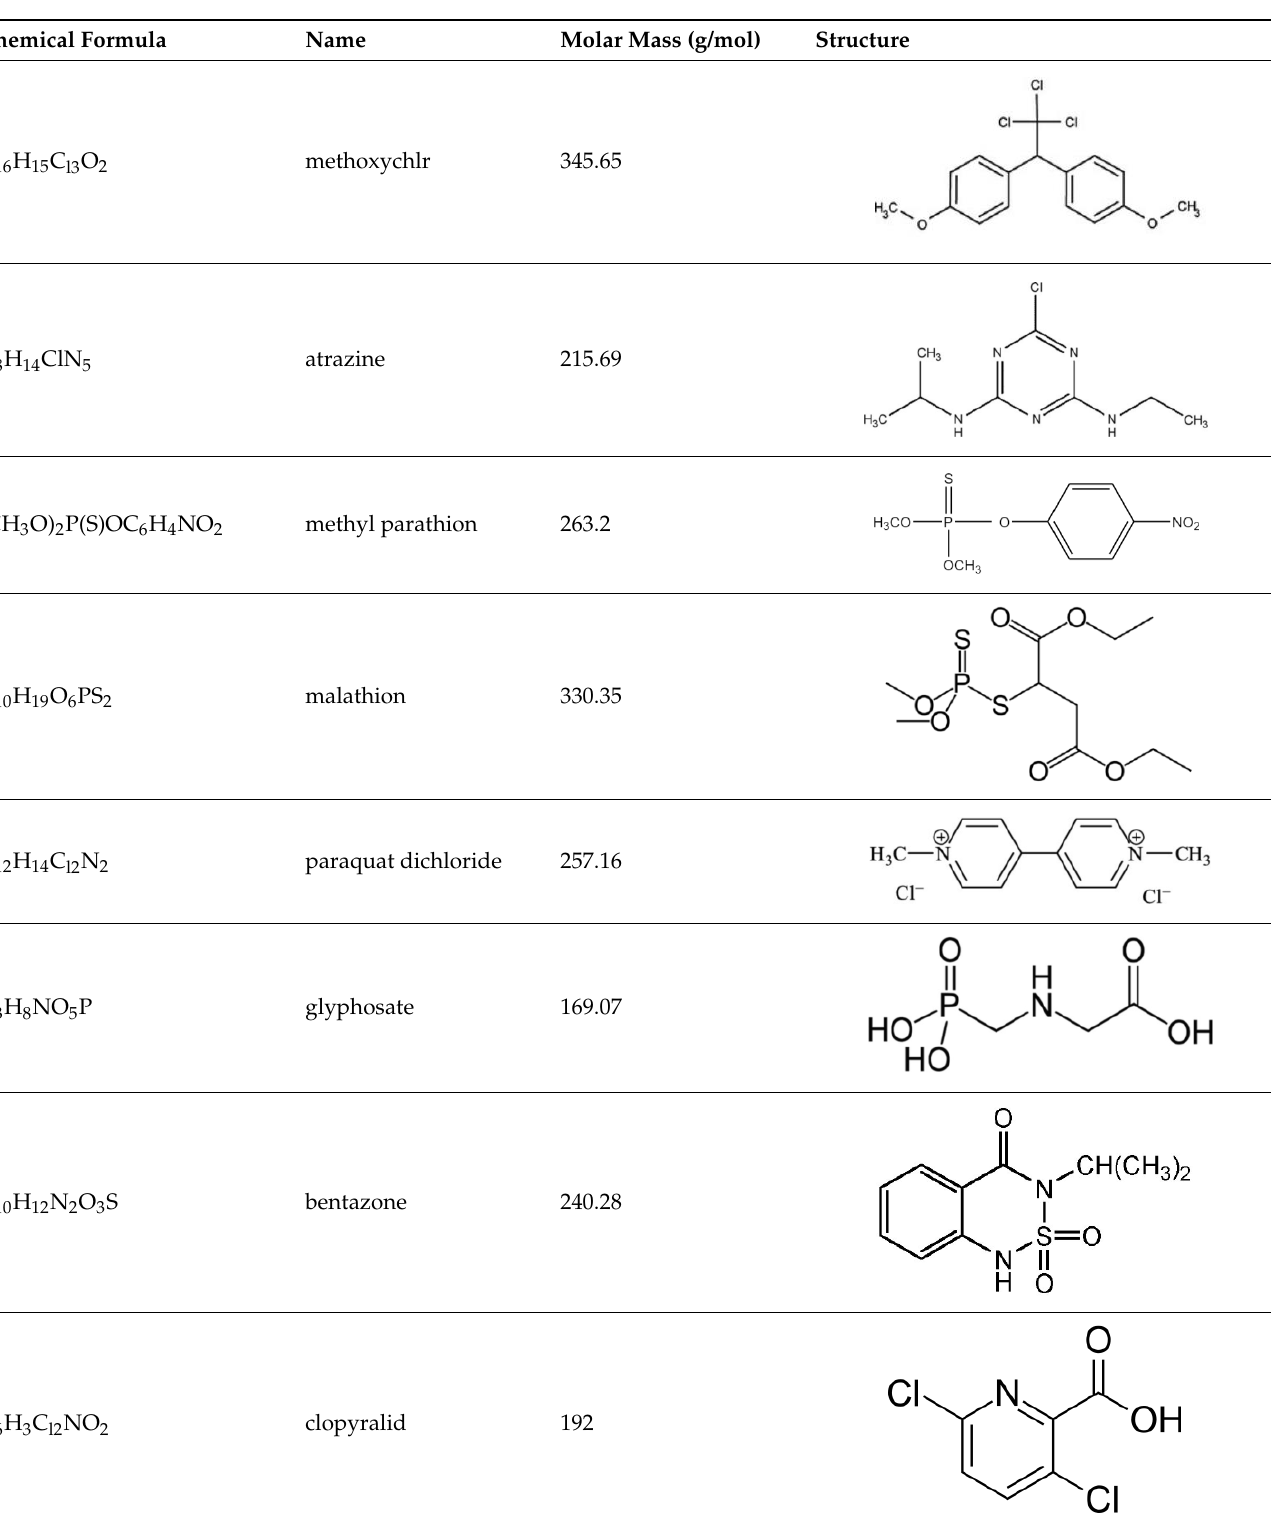
Table 6. Chemical formula, molar mass, and structure of the pesticide.